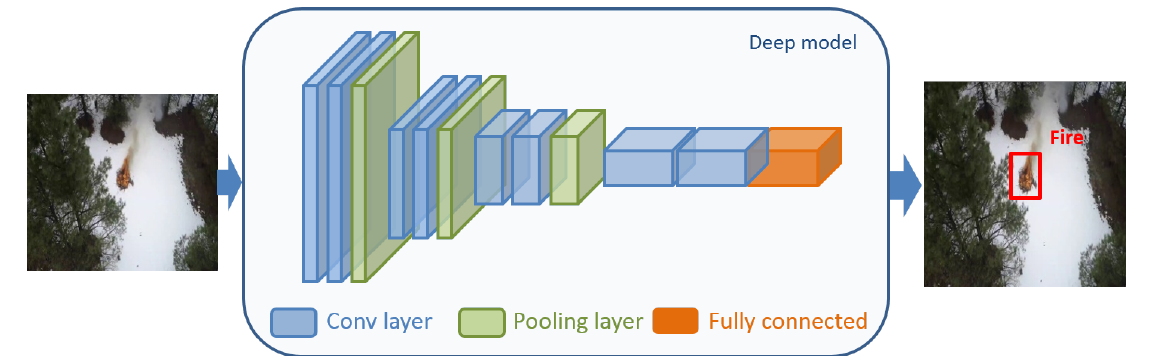
Figure 2. Wildland fire detection based on DL